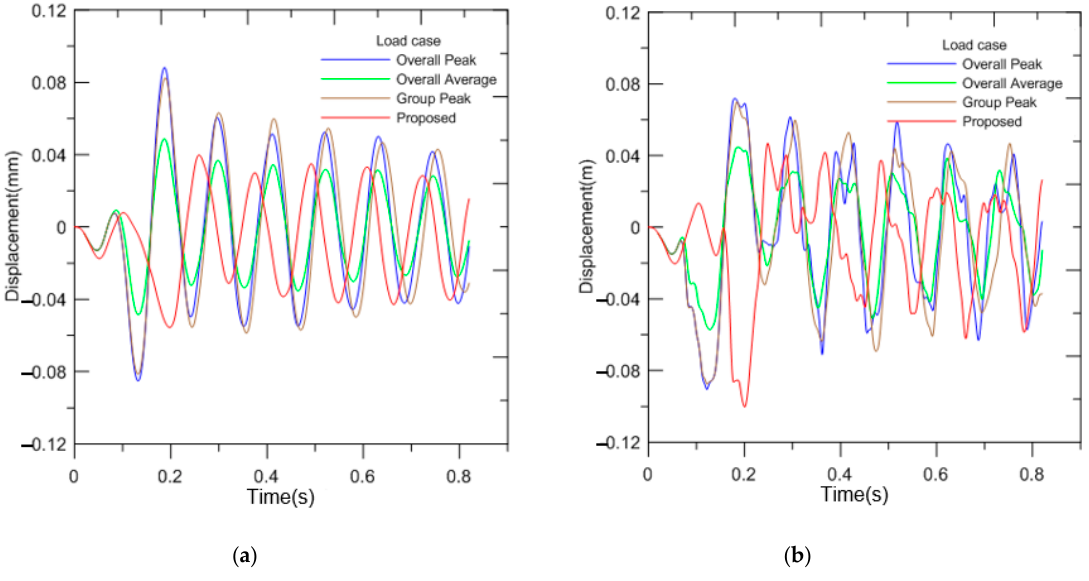
Figure 17. Displacement of ( a ) frame and ( b ) plate (material: S235). Table 8. Minimum and maximum displacements of frame (m).